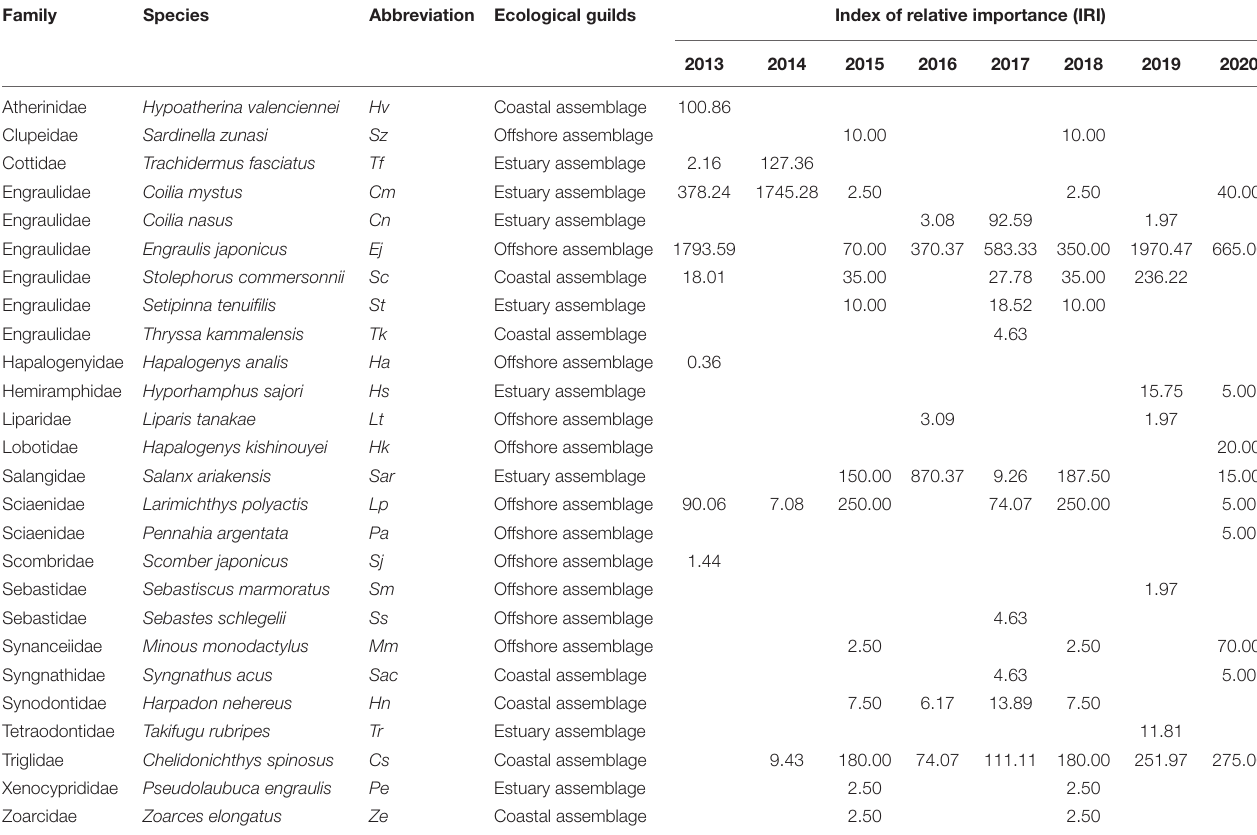
TABLE 1 | The basic ichthyoplankton information in the Yangtze Estuary in spring 2013–2020. Family Species